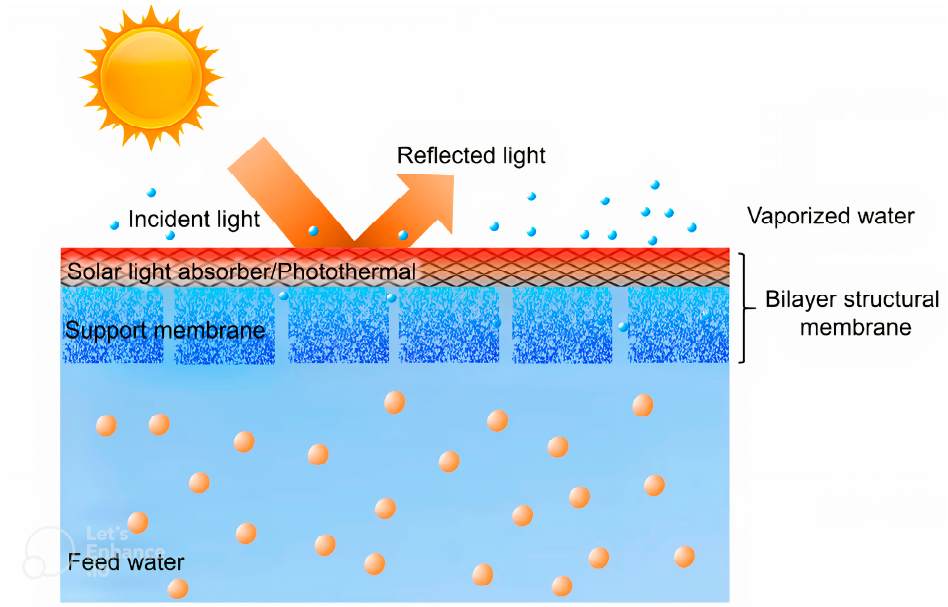
Figure 15. A photothermal membrane in general [230].